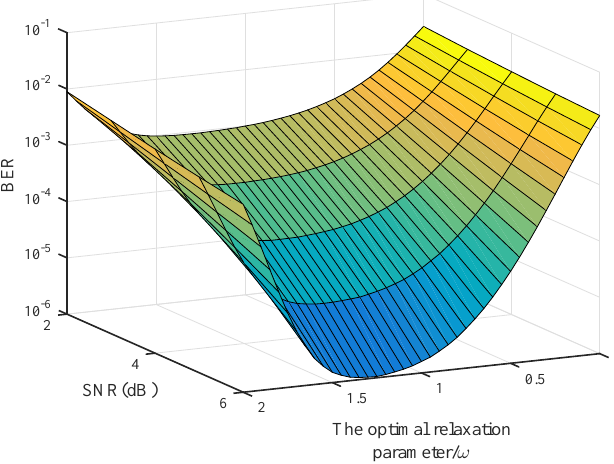
Figure 6. Impact of the relaxation parameter on BER (128 ×